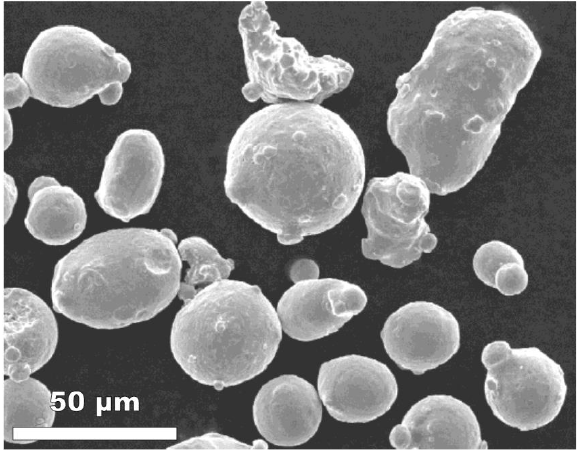
Figure 4. SEM micrograph showing irregular morphology of the Inconel 625 powders.